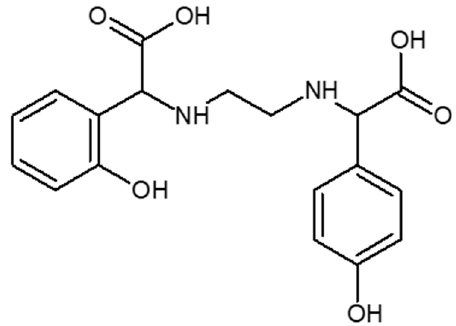
Figure 1. Structure of ethylenediamine- N,N ′ -di[( ortho -hydroxyphenyl) acetic] ([ o , o ] EDDHA).